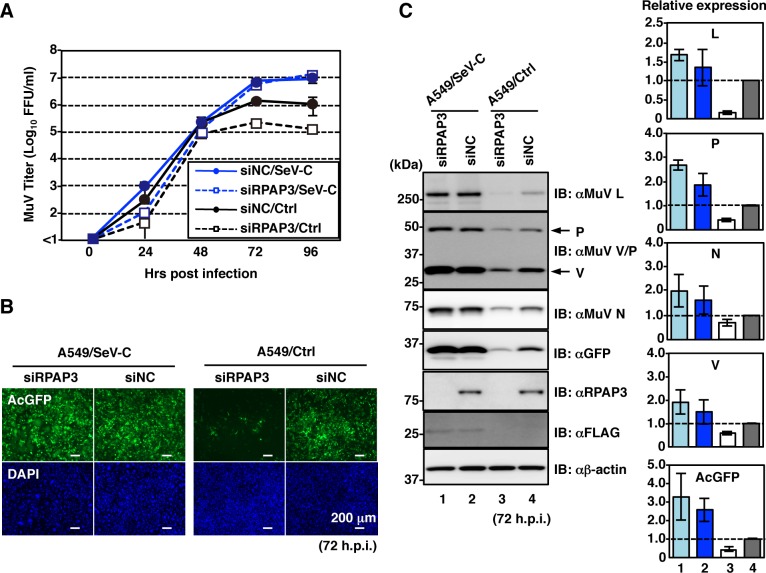
Host antiviral responses restrict MuV propagation in RPAP3-knockdown cells.At 48 h post-transfection with either siRPAP3 or siNC, A549/SeV-C and A549/Ctrl cells were infected with rMuV/AcGFP at a MOI of 0.05. (A) Supernatants were collected at 0, 24, 48, 72 and 96 hpi, and infectious titers were determined by plaque assay. (B) At 72 hpi, cells were observed under a fluorescence microscope. (C) At 72 hpi, cell lysates were immunoblotted with the indicated antibodies. The relative band intensities of each viral protein were normalized to β-actin level, and the relative expression of each protein based on levels in siNC-treated A549/Ctrl cells is shown. Error bars indicate the standard deviations of triplicate wells.